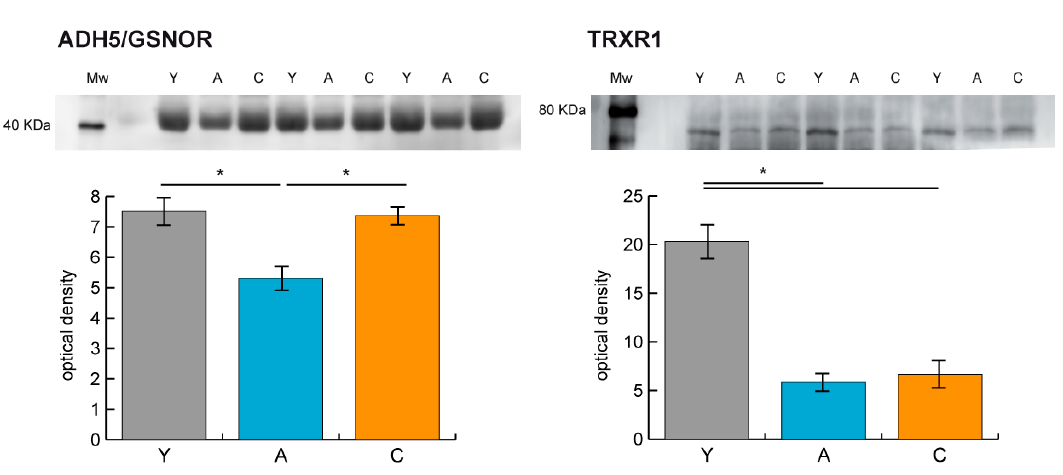
Figure 8. Representative histograms and immunoblot images of alcohol dehydrogenase 5/S- nitrosoglutathione reductase (ADH5/GSNOR) and thioredoxin reductase 1 (TRXR1) (mean ± SD; * = significant difference, ANOVA and Tukey’s test, n = 3, p -value < 0.05) in aged (A), young (Y), and centenarian (C)